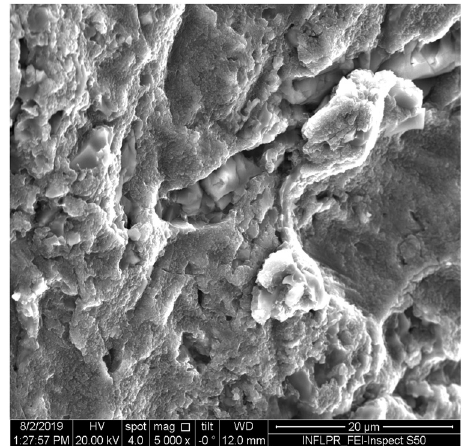
Figure 11: SEM image of sample S11 at a magni fi cation of 5k × .